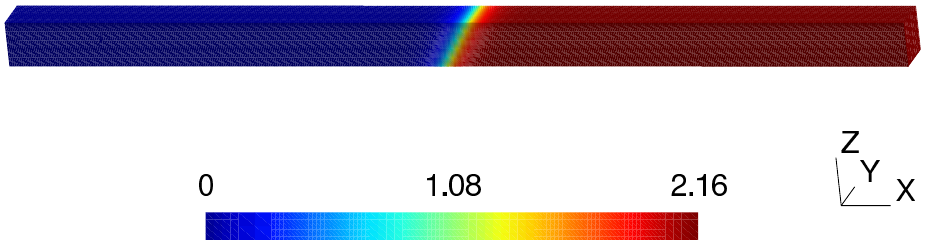
Figure 7. Displacement u for the α = 30 ◦ discontinuity, h = L/ 500 , ρ/h = 5 and support x = 40 ρ width ℓ ρ